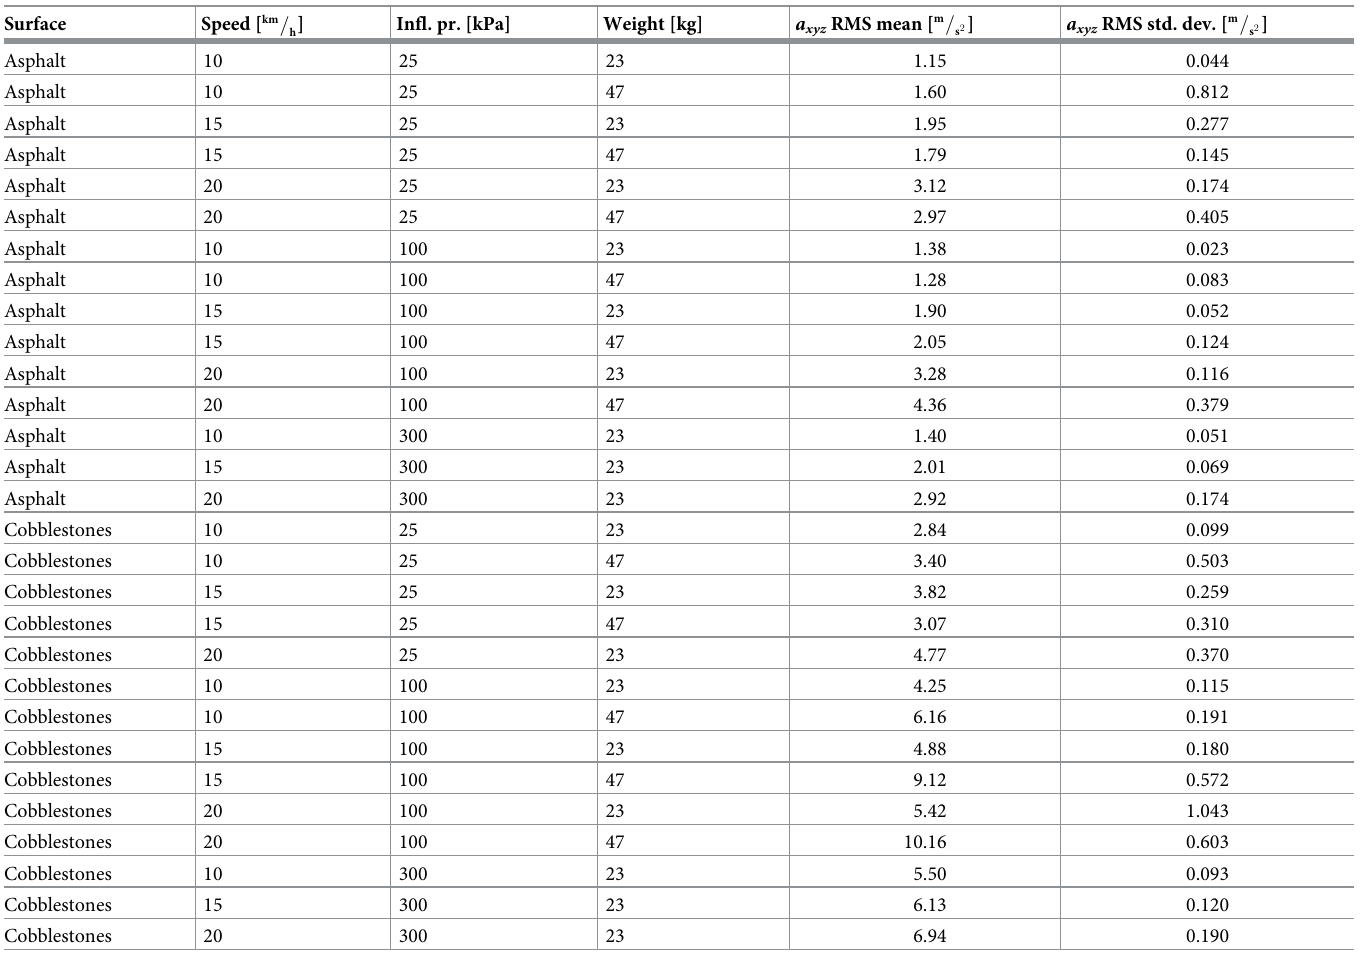
Table 1. RMS values for outdoor tests with child carrier.